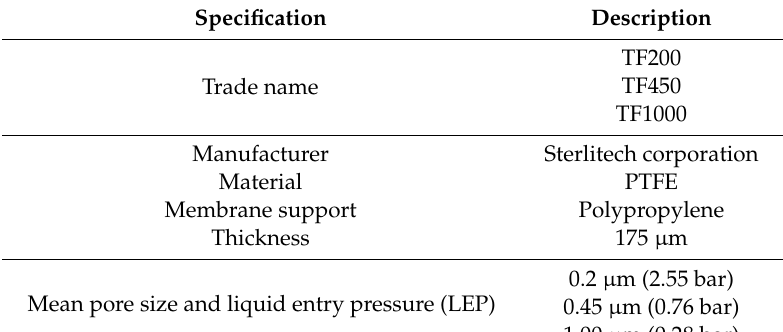
Figure 1. Schematic diagram of the air gap membrane distillation (AGMD) experimental apparatus used in this study. Table 2. Properties of membranes that were used in this work as specified by the manufacturer. PTFE: